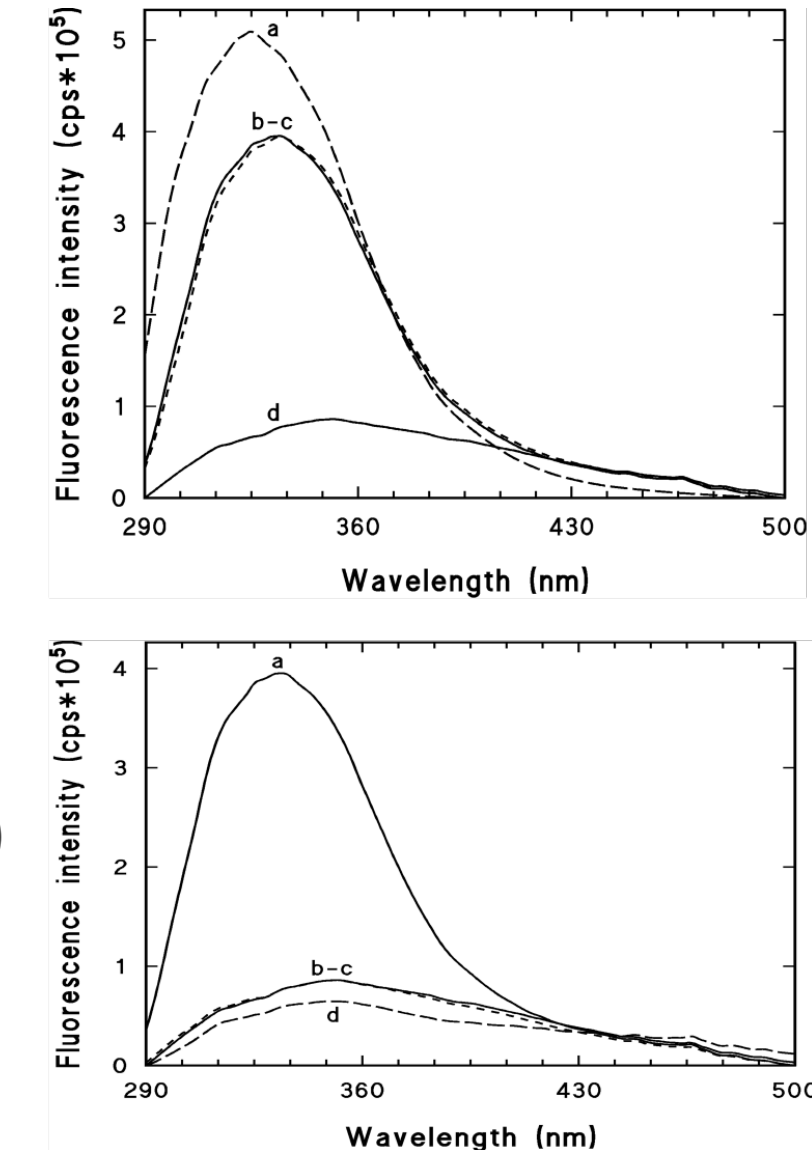
Figure 5. ( a ) The fluorescence emission spectra of BSA solution (a), LBG and physical mixture of BSA–LBG 1:6 (b–c), and BSA–LBG 1:6 conjugate (d); ( b ) the fluorescence emission spectra of BSA solution (a), BSA–LBG 1:3 and 1:6 conjugates (b–c), and when added apigenin